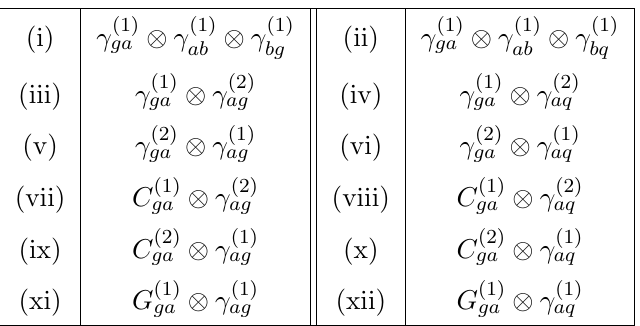
Table 3 . Convolutions appearing at the N 3 LO-only between the collinear C ( n ) , the helicity-(cid:13)ip ab G ( n ) and the splitting functions (cid:13) ( n ) ( n = 1 ; 2). The repeated subindices a and b imply a sum ab ab over the parton (cid:13)avors q; (cid:22) q; g . The (cid:12)rst and last subindices denote the partonic channel in which they are contributing, i.e. the convolutions in the (cid:12)rst column are used in the gg partonic channel whereas the second (and last) column is for the qg and gq partonic